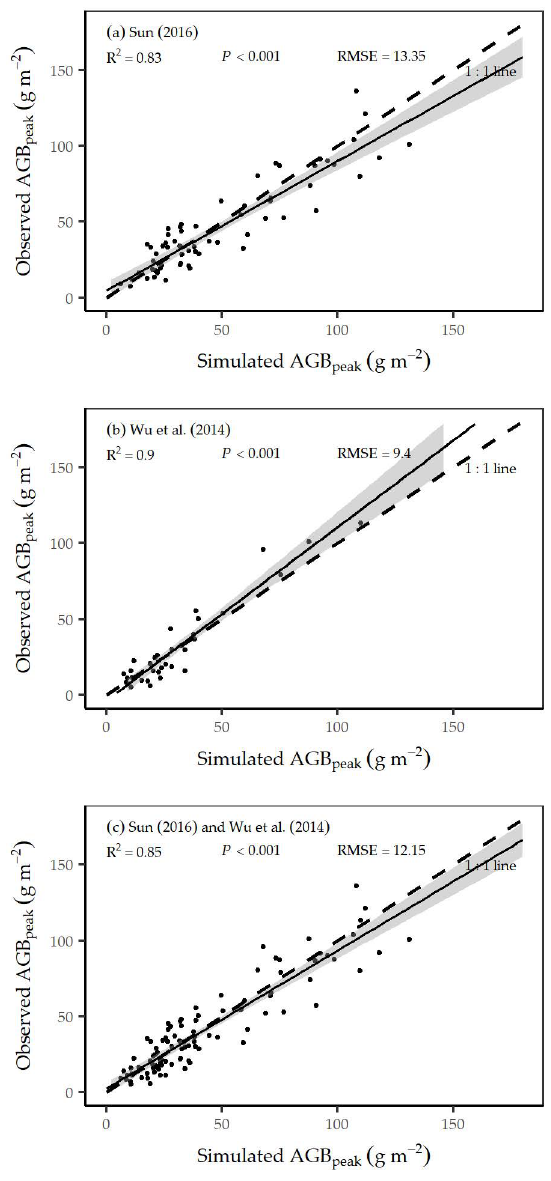
Figure 2. Validation of the best-fitted linear AGB peak -GEVI model by comparing the observed AGB peak from ( a ) Sun [47], ( b ) Wu, et al. [48], and ( c ) both of them (see Figure 1 for site locations) with the simulated AGB peak values. The coefficients of determination (R 2 ) and the significance level ( p values) of the linear relationships between the observed and simulated AGB peak were given. The root mean square error (RMSE) and the 1:1 line (dashed ones) were also given to show the standard deviation of the simulated values from the observed